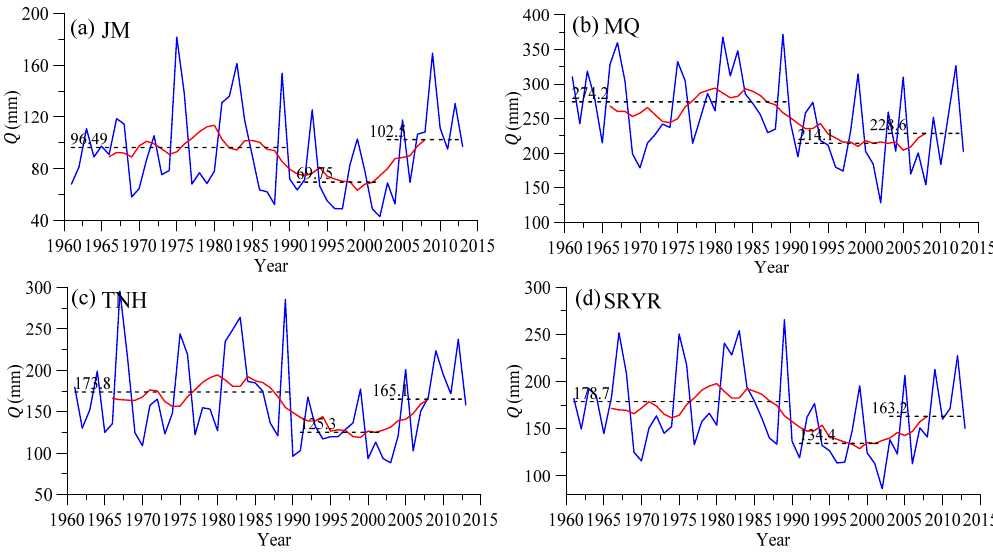
Figure 4. Time series of annual discharge, Q , in the three sub‐basins and the source region of the Yellow River (SRYR). The dashed, red, and blue lines indicate the mean values in different periods, 11 year moving average value, and annual mean value of discharge, respectively.